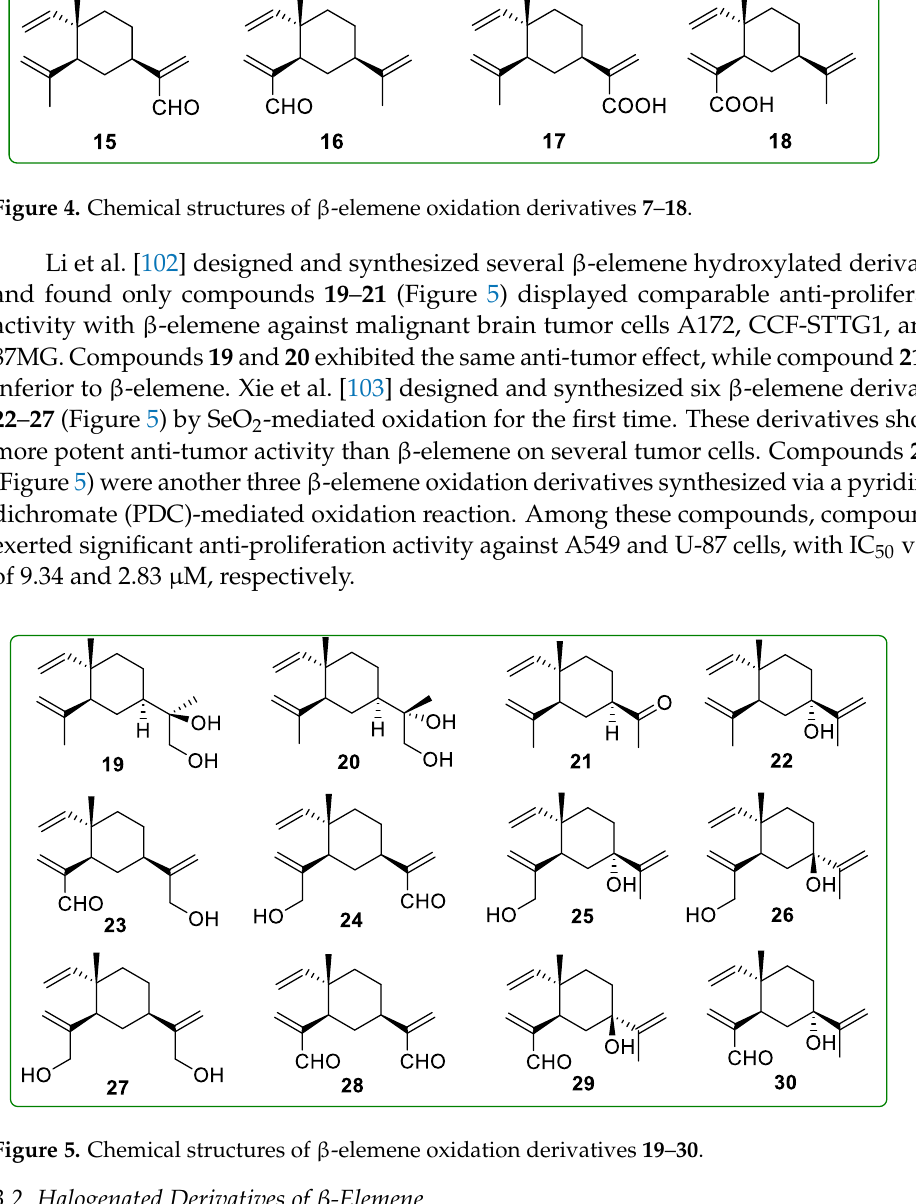
Figure 5. Chemical structures of β -elemene oxidation derivatives 19 – 30 .